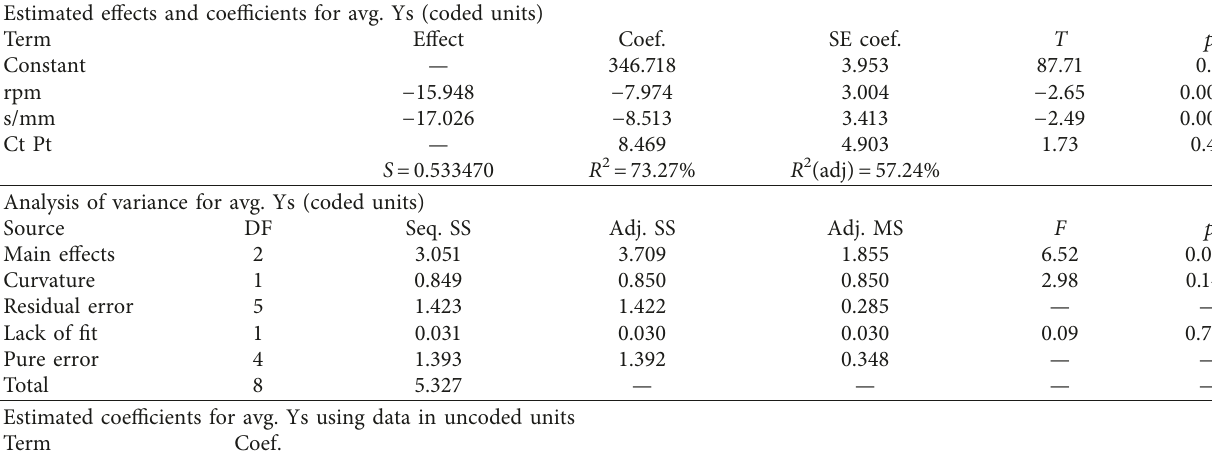
Table 4: Results of yield strength weighted analysis of variance.